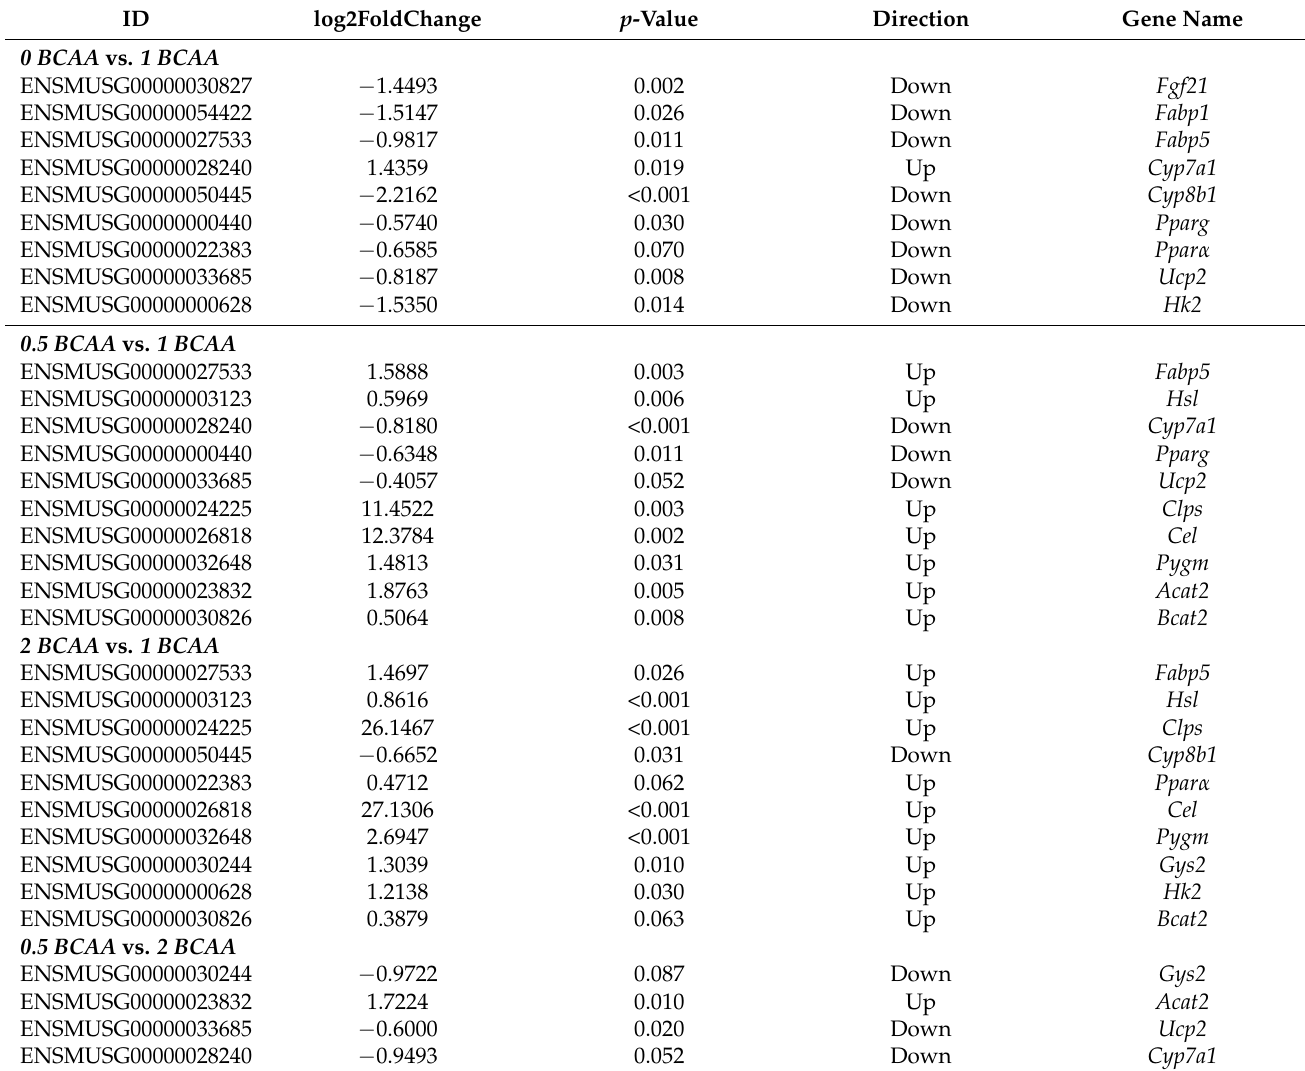
Table 1. Selected significant differentially expressed genes from transcriptomic